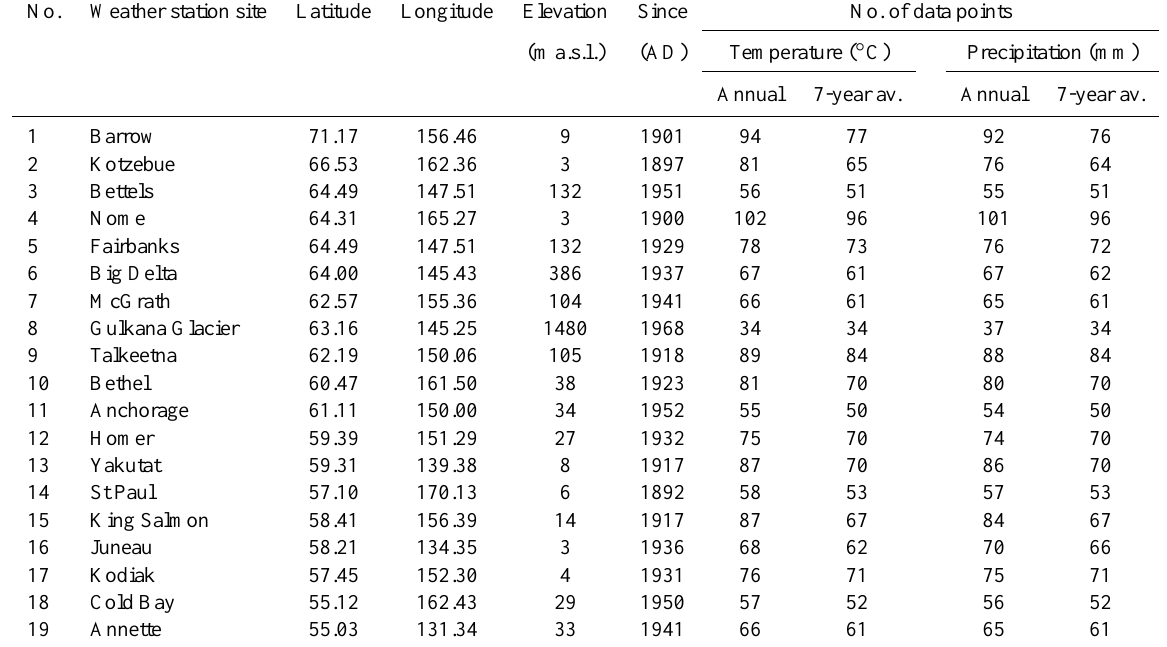
Table 2. Information on meteorological data